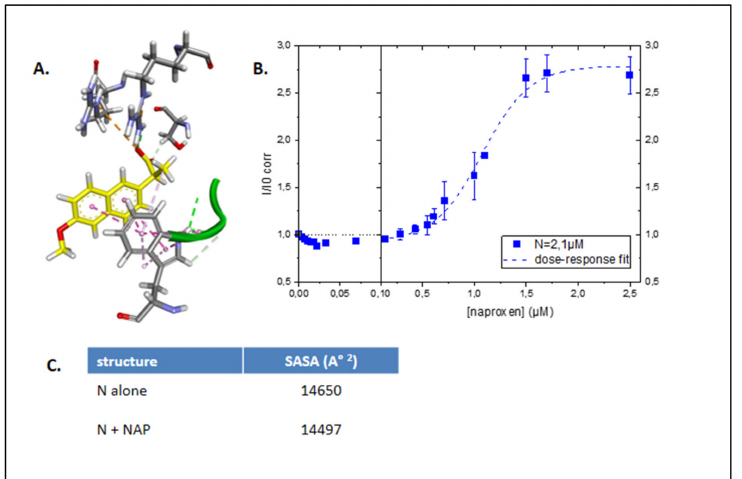
Figure 3. Naproxen binds to recombinant N-terminal domain of SARS-CoV-2 N. ( A ): Close-up view of naproxen interacting with W52 (PDB 6VYO). ( B ): Normalized intrinsic fluorescence of N, corrected for the inner filter effect, as a function of naproxen concentration using 2.1 µ M N in 20 mM Tris buffer pH = 7.9, 100 mM NaCl. ( C ): evaluation of the solvent-accessible surface area in the N dimer without and with